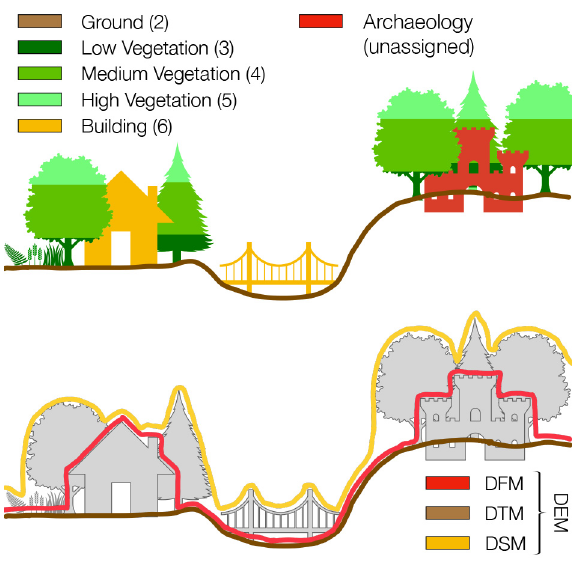
Figure 1. An outline of the differences between digital elevation model (DEM), digital feature model (DFM), digital terrain model (DTM), and digital surface model (DSM) (After [32]: Figure 1, published under CC-BY 4.0).